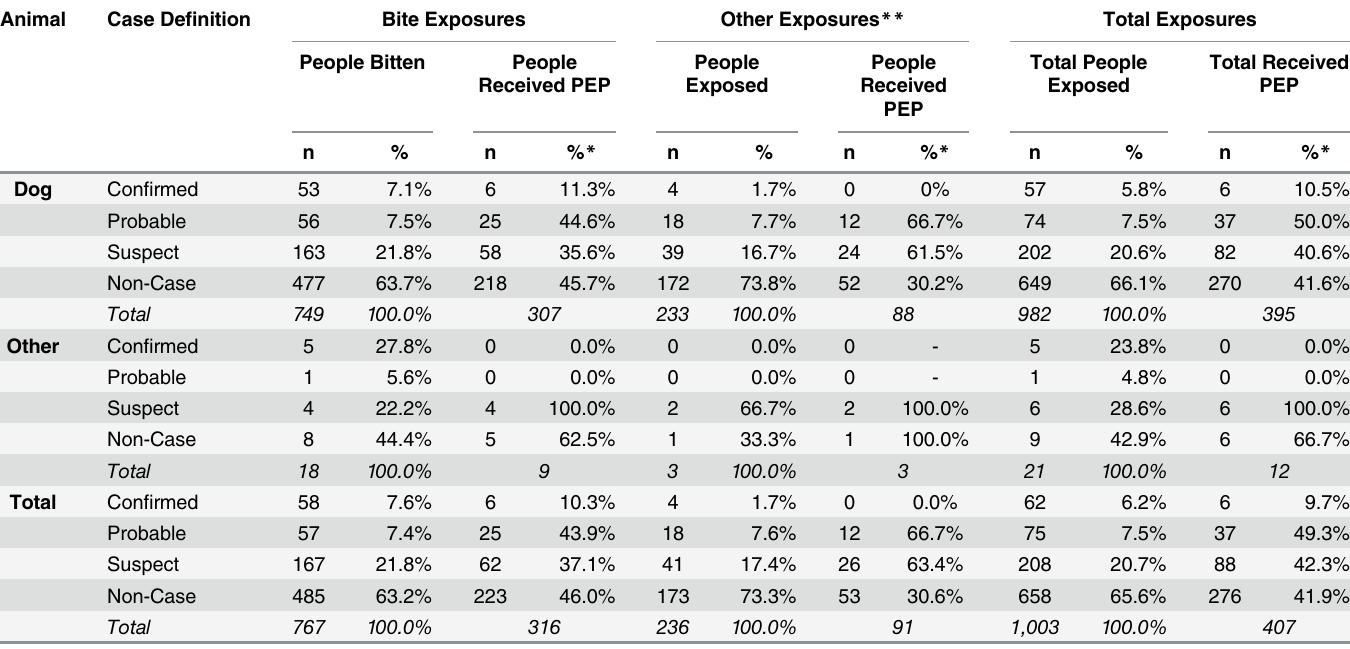
Table 3. Human exposures to rabies suspect animals by case status and species, Haiti January 2013 – December 2014. Animal Case De fi